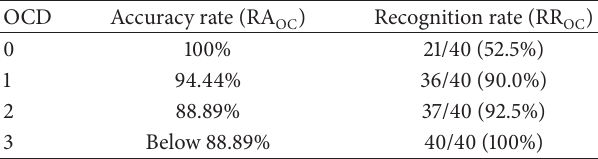
Table 2: Accuracy and recognition rates according to OCD.